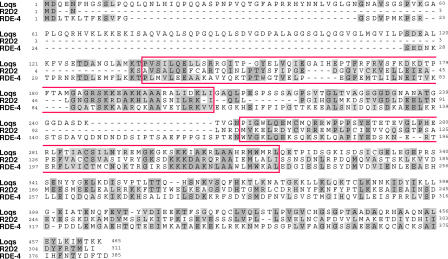
Loqs/CG6866 Is a Paralog of R2D2A protein sequence alignment of Loqs, R2D2, and RDE-4 (C. elegans). The two canonical dsRBDs are boxed. Conserved residues are shaded in gray. It is noted that the C-terminal region of Loqs contains a non-canonical dsRBD (see Figure 8).